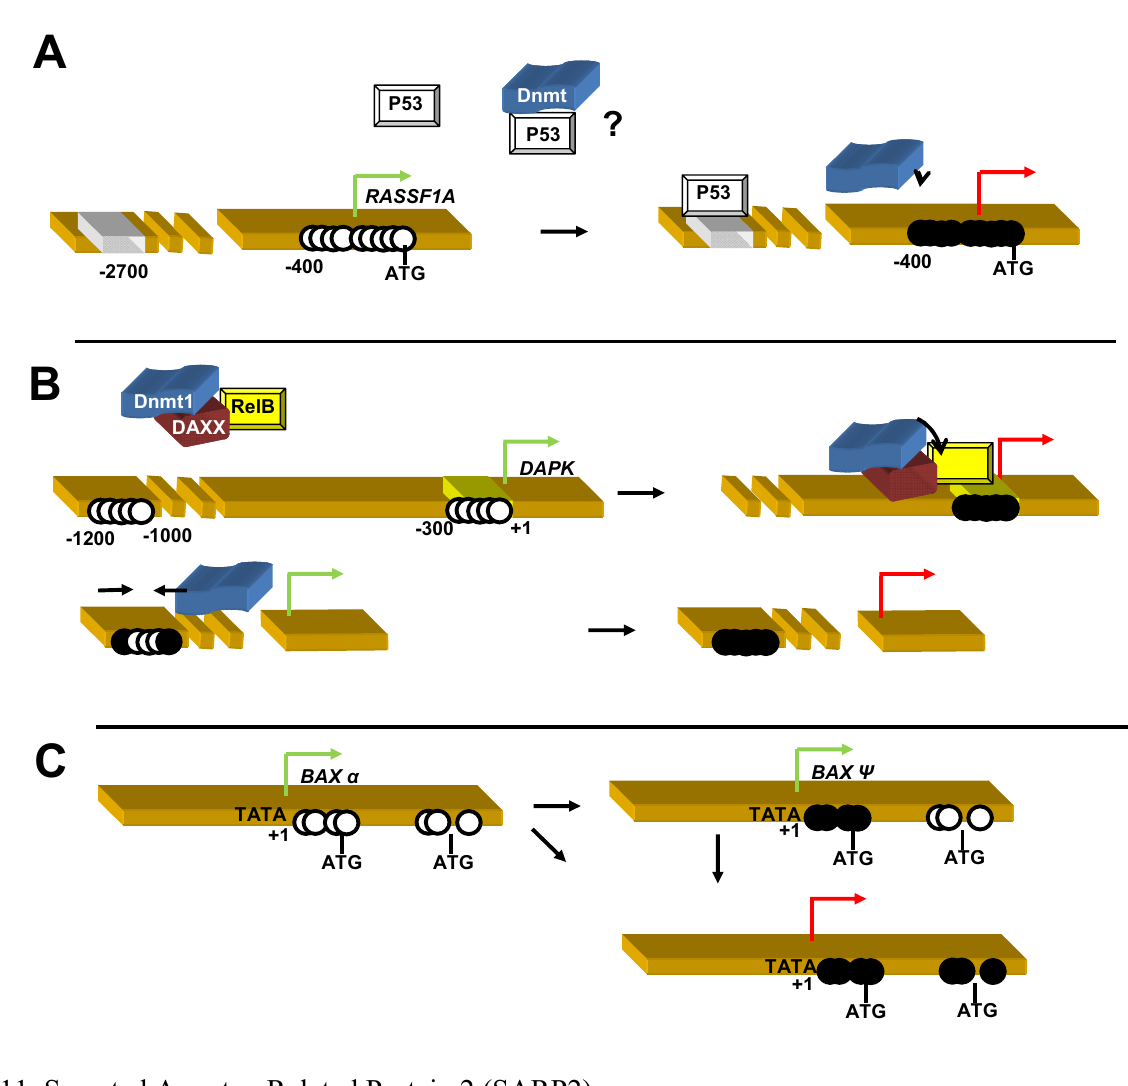
Figure 2. Mechanisms of DNA hypermethylation and apoptosis-related genes inactivation ( a ) Inactivation of RASSF1A by Dnmt/P53 cooperation. ( b ) Inactivation of DAPK by the ternary complex Dnmt/RelB/DAXX. (c) Specific methylation of BAX leading to BAX ψ or BAX